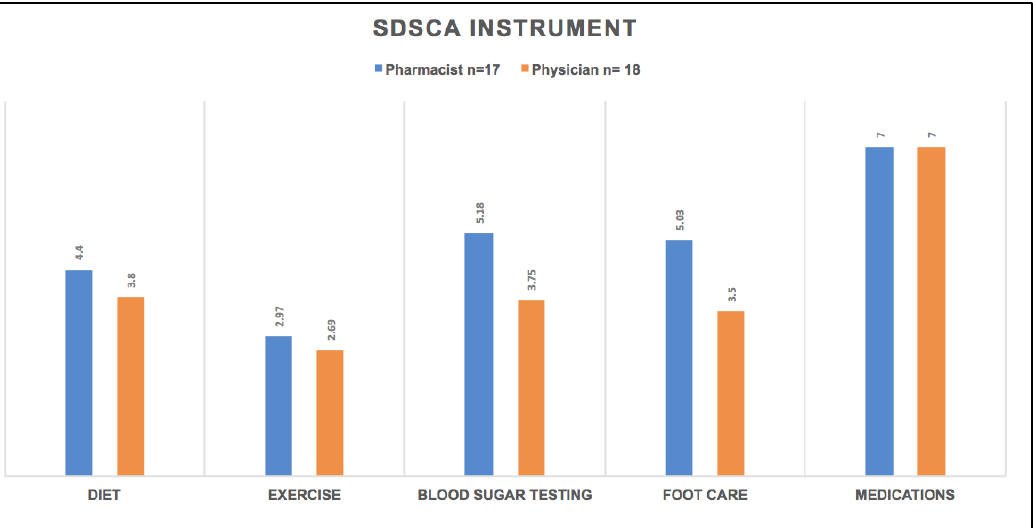
Figure 2. Summary of Diabetes Self-Care Activities (SDSCA).